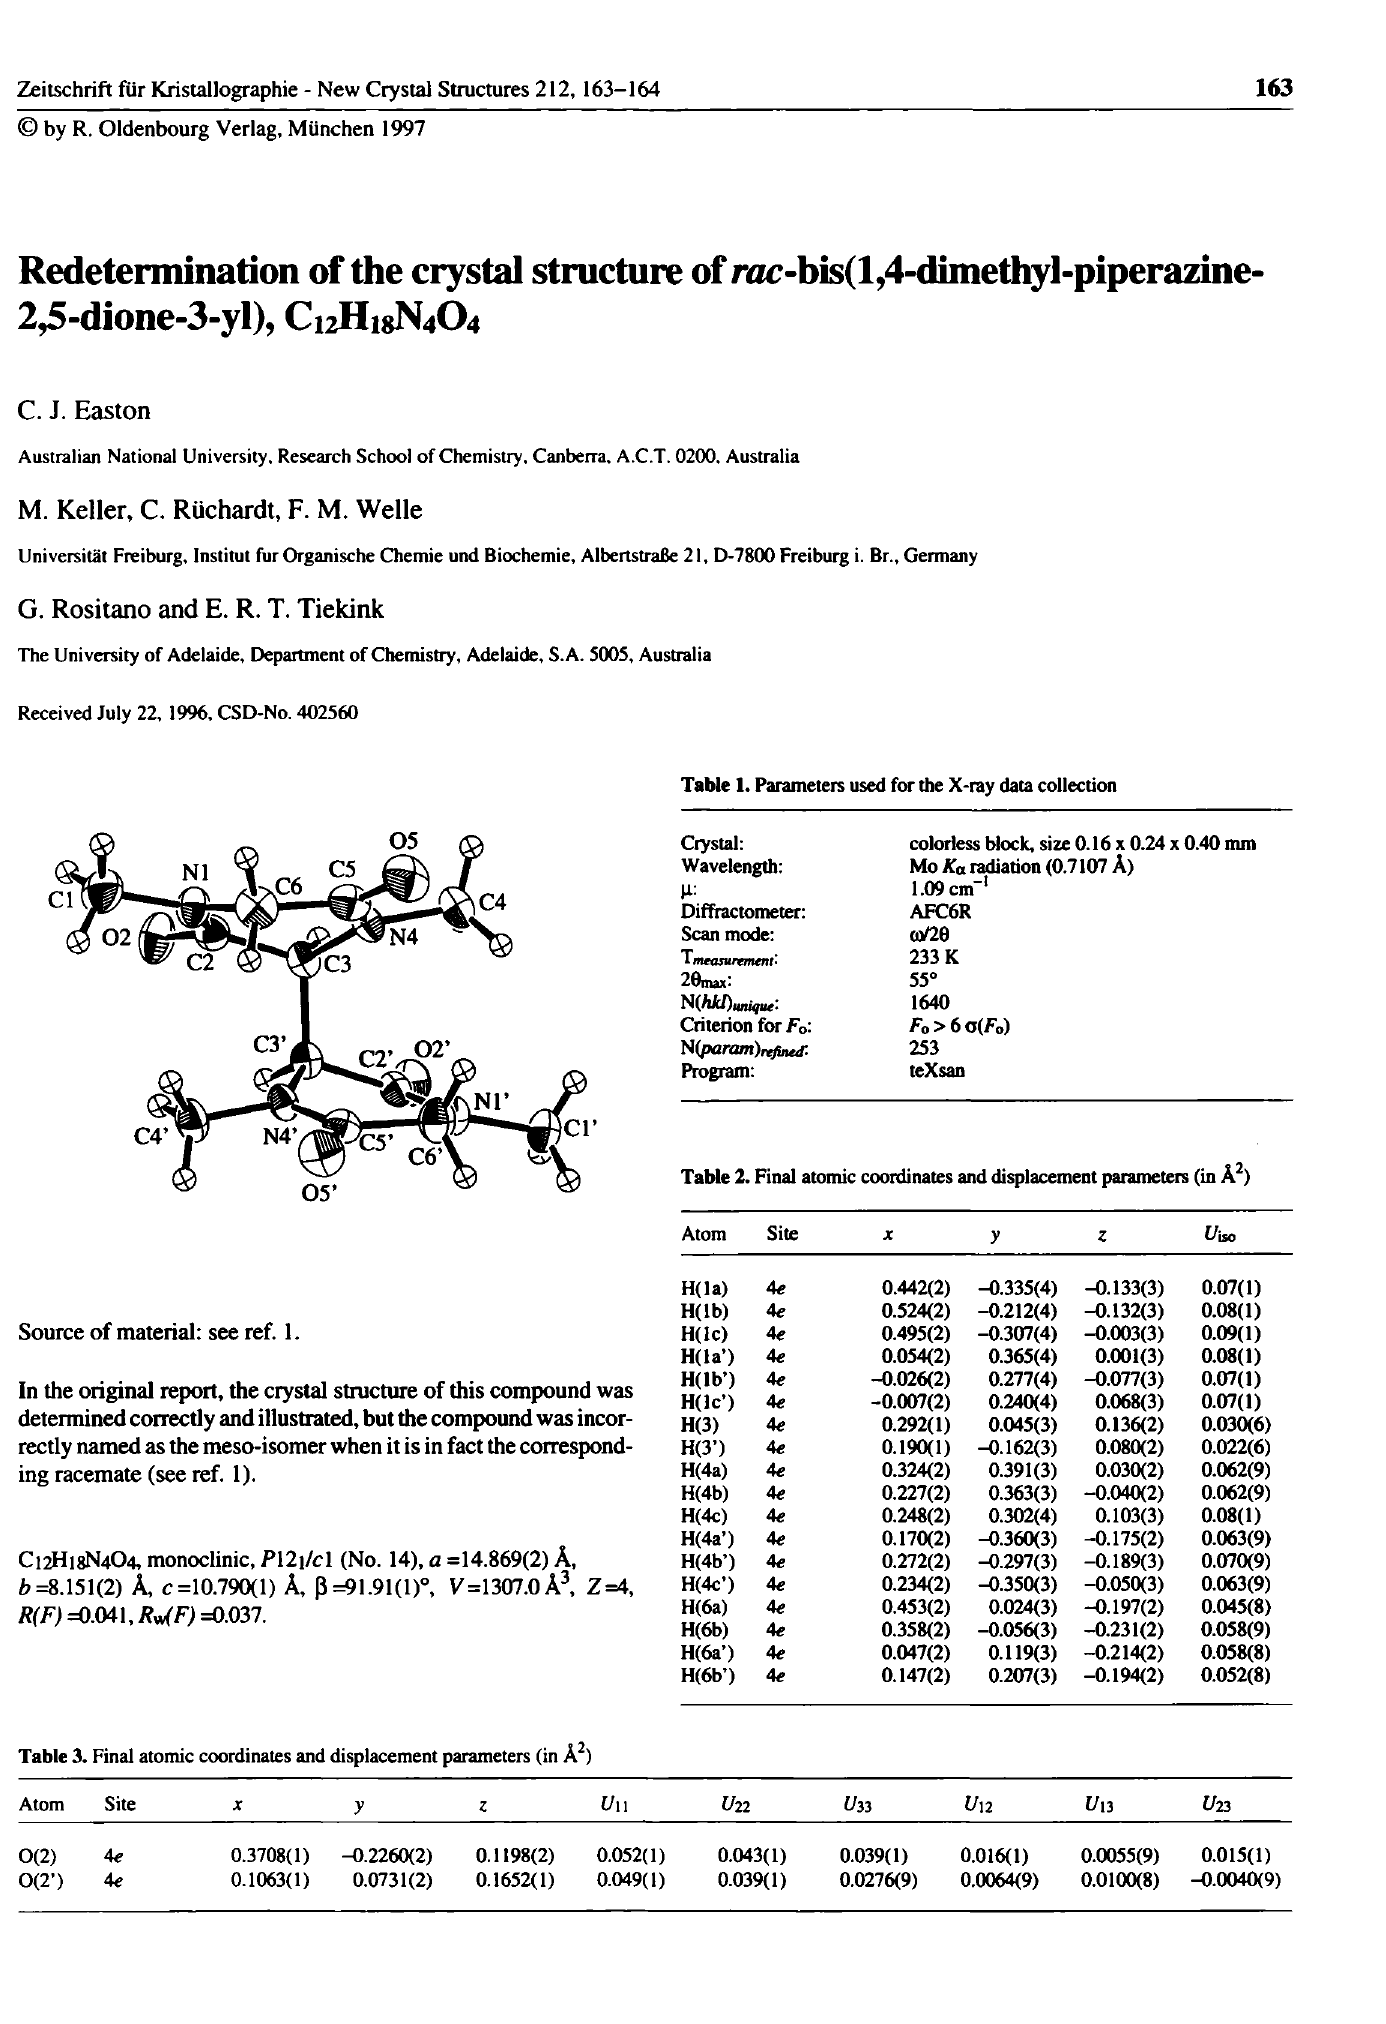
Table 3. Final atomic coordinates and displacement parameters (in A 2